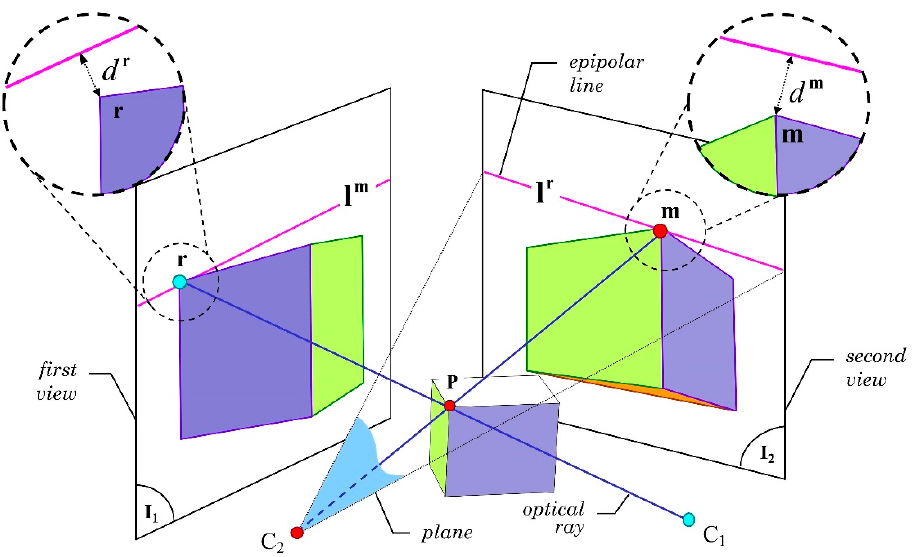
Figure 2. The epipolar geometry of an object in the 3D space and its projections in 2D planes.